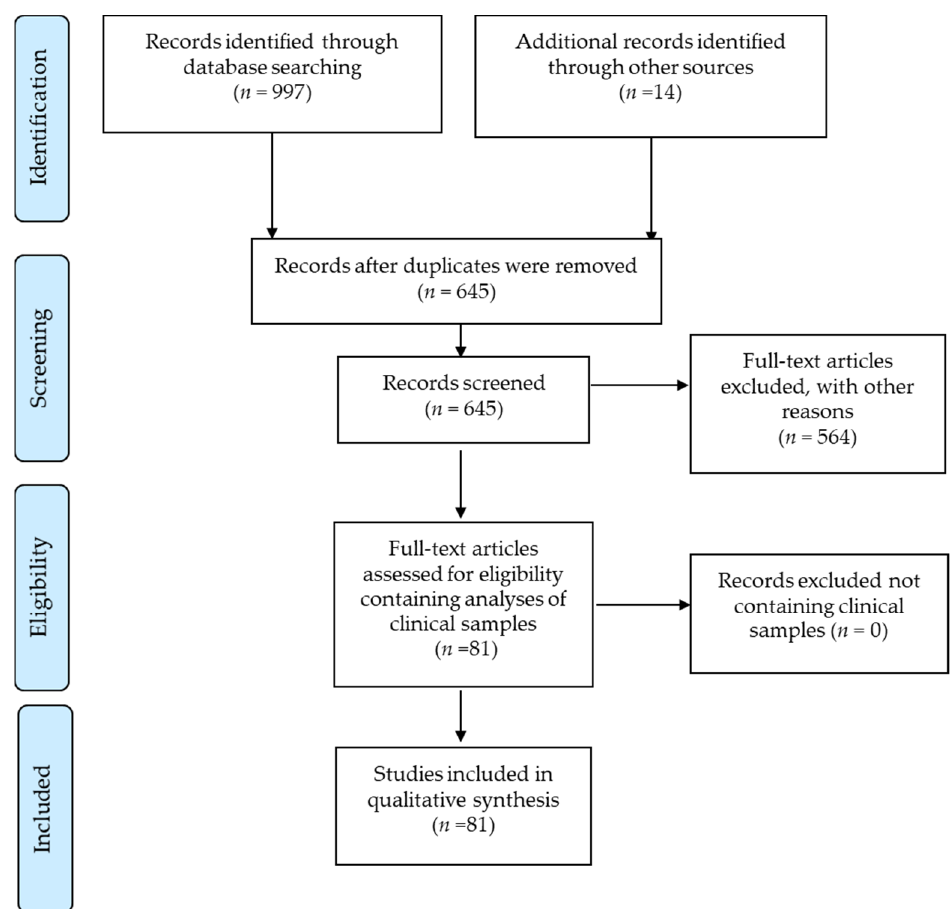
Figure 1. PRISMA 2009 Flow Diagram (from Mober D, Liberti A, Tetzlaff J, and Altman DG; The PRISMA Group (2009). PreFigure 6. e 1000097 (access until 31 August 2021). For more information, visit WWW.prisma-Statement.org (access until 31 August 2021). Other sources appear as indicated.